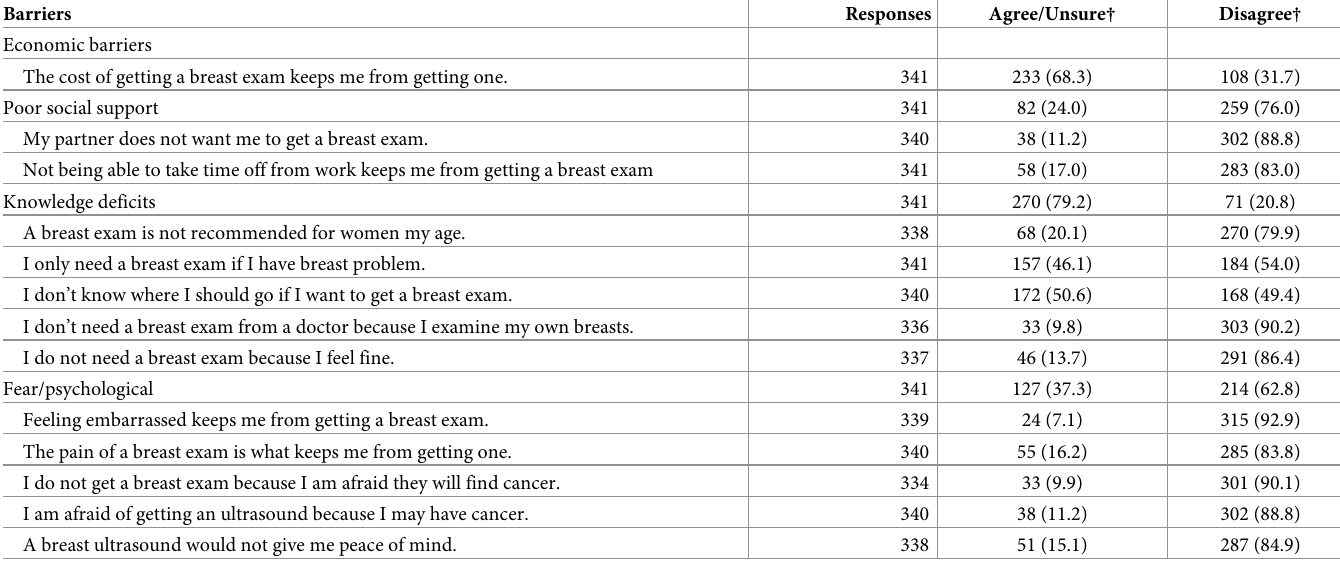
Table 2. Patient-related barriers to breast cancer early